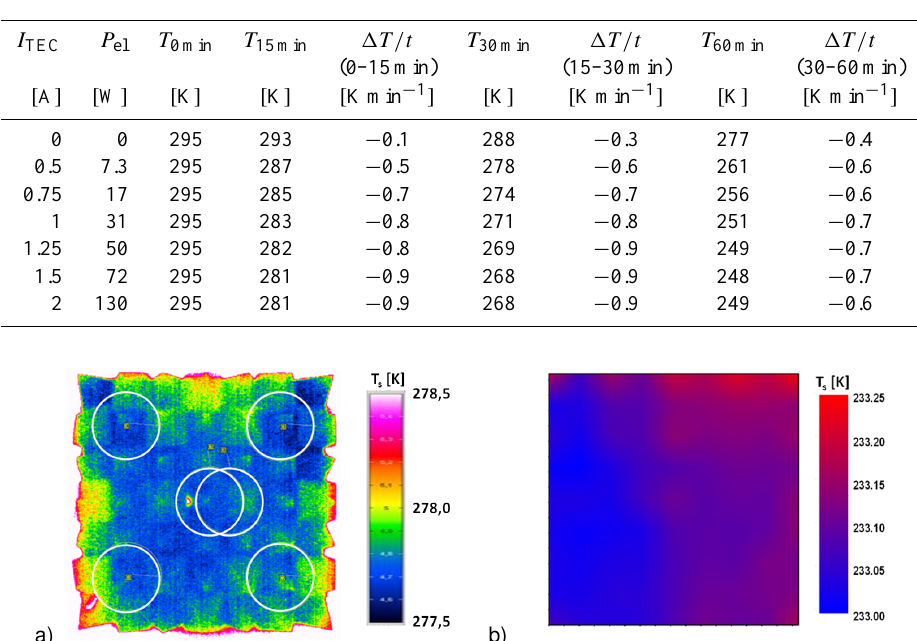
Table 4. Temperature and cooling rate for the GBB optical surface as a function of the electrical current, taking into account changes in ambient temperature and pressure.